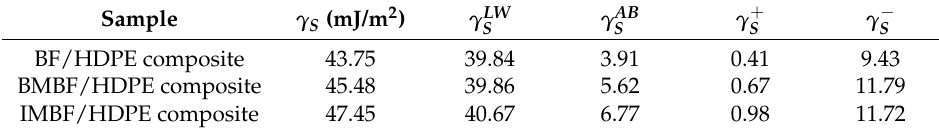
Table 3. Surface energy calculated by acid-base model according to Lewis equation. Sample